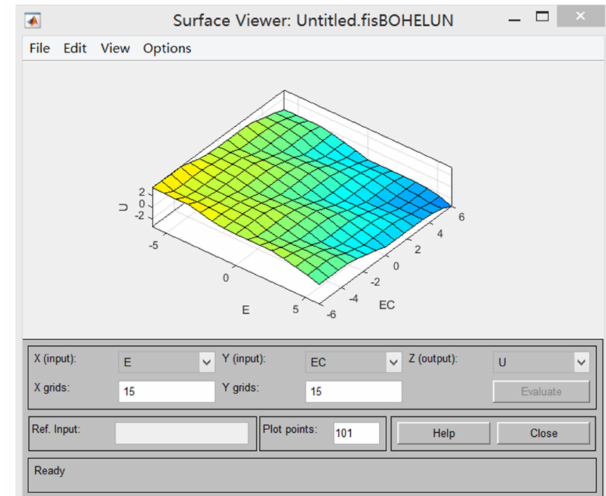
Figure 13. Surface